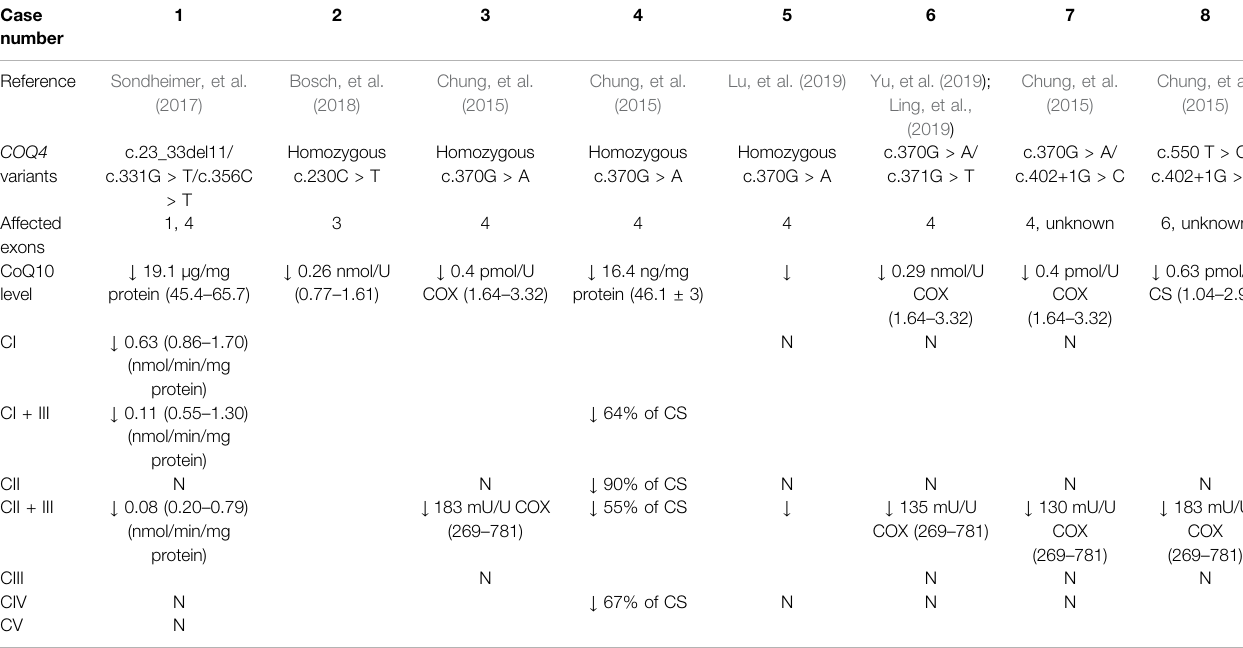
TABLE 4 | Biochemical analysis of skin fi